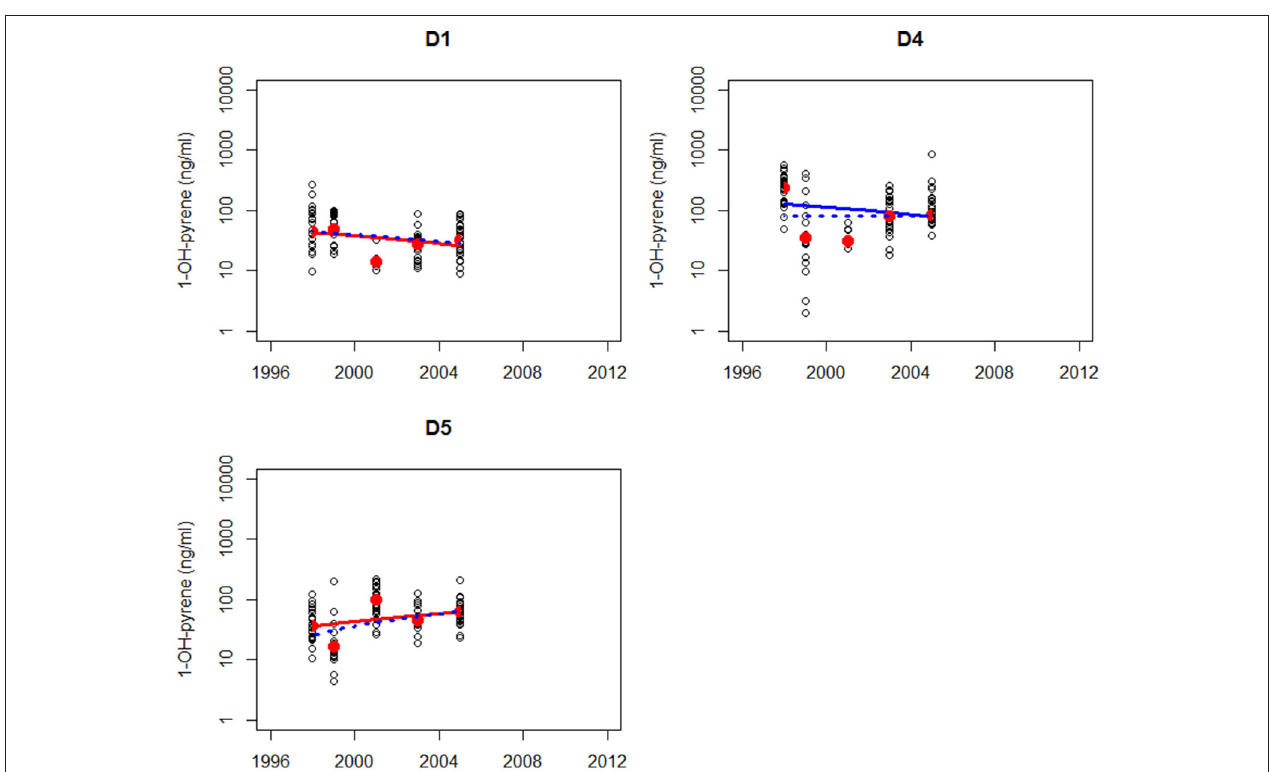
FIGURE 3 | Non-parametric trend analysis of annual medians (red dots) of 1-OH-pyrene in bile fluid of dab on site D1, D4, and D5 (off-shore in the North Sea). Trend line shown is the Theil-Sen slope (solid line is based on all results and dotted line is based on annual medians). A statistically significant trend is indicated with a red line, otherwise the line is